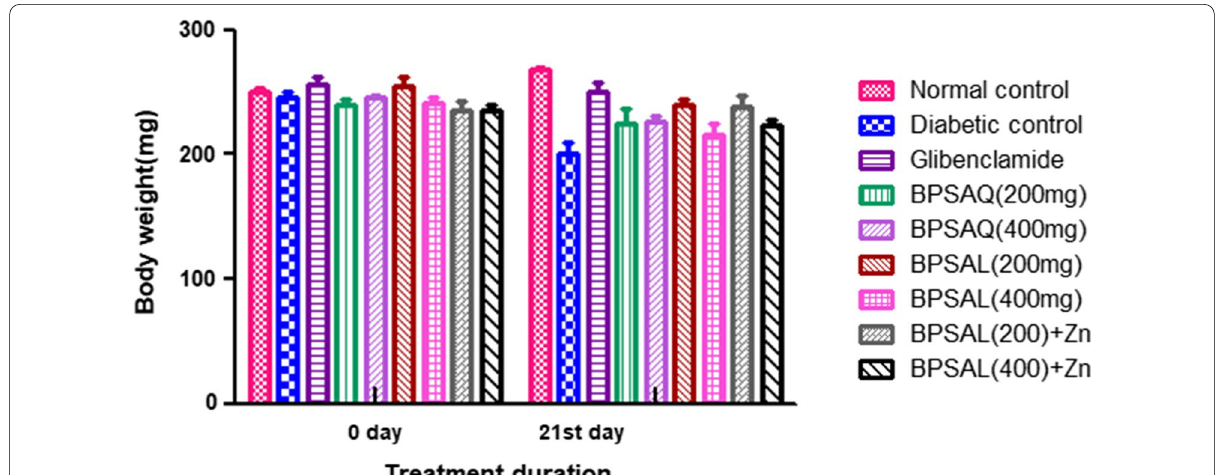
S.E.M ( n 6); ** P < 0.001 significant from diabetic ± = =